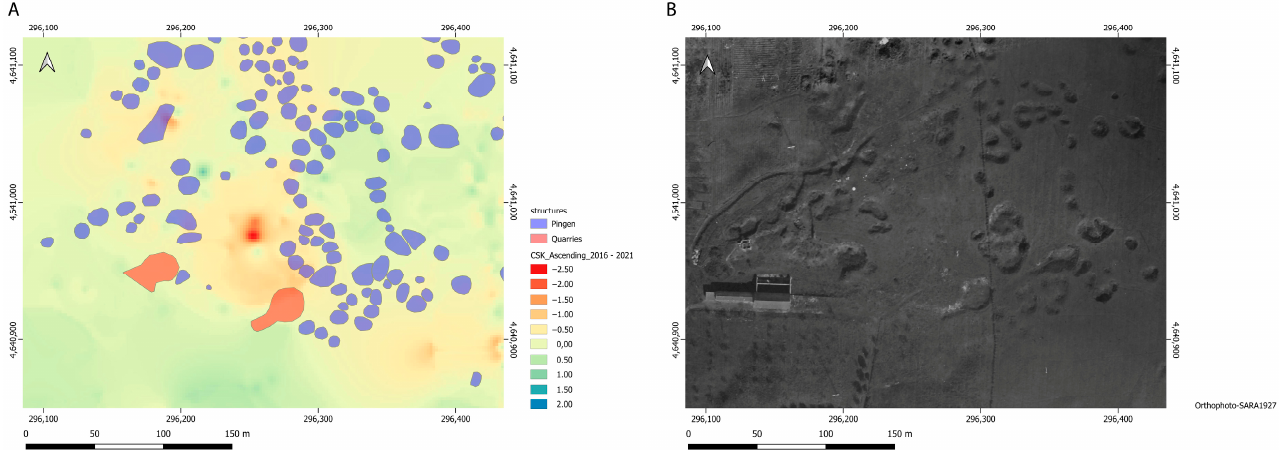
Figure 16. ( A ) Detail of the pingen field, described by the vector Structures overlapped on the interpolation map (CSK_RA); ( B ) the corresponding localization of quarry-related structures in the photograph (SARA_1927). Photographs from © ICCD—Aerofototeca Nazionale, Fondo SARA, (SARA_1927). Photographs from © ICCD—Aerofototeca Nazionale, Fondo SARA, flight flight 1927.